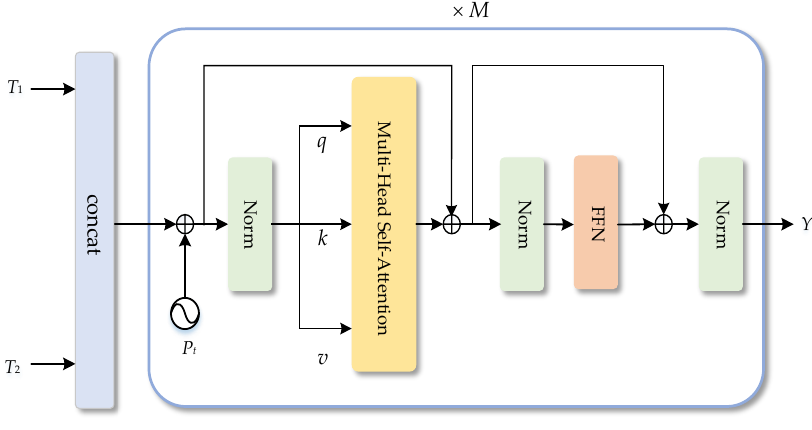
Figure 7. The structure of